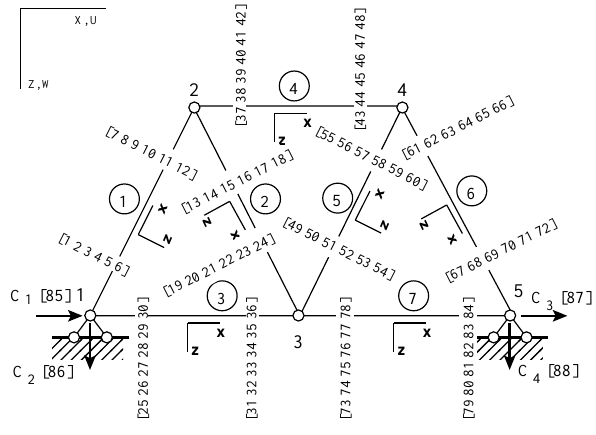
Fig. 11. Indices of state vector components for a seven-bar truss with distributed